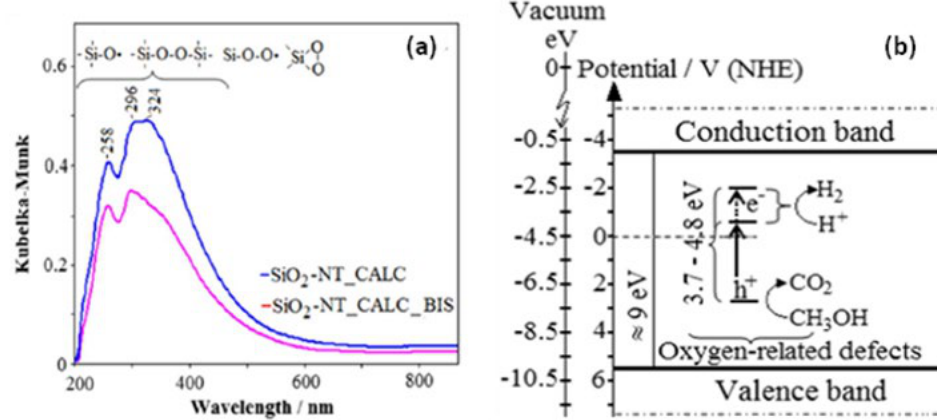
Figure 3. ( a ) Comparative UV-Vis spectra of silica nanotubes subjected to calcination in air for 3 h (SiO 2 -NT CALC) and 1 h (SiO 2 -NT CALC–BIS) ( b ) Representation of intraband gap defects in tubular SiO 2 Reproduced with permission from ref. [33]. Copyright 2023 Elsevier.